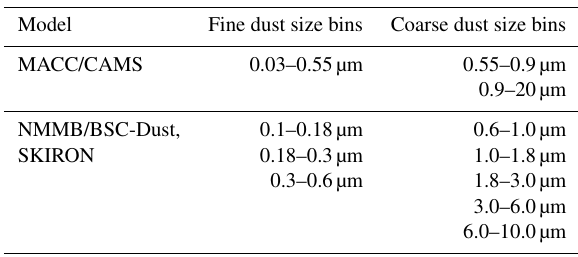
Table 1. Size bins (radius intervals) considered in the dust forecast models MACC/CAMS, SKIRON, and